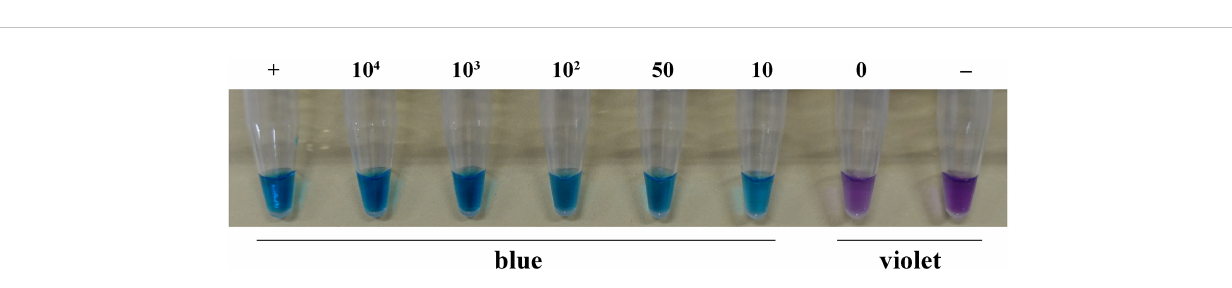
FIGURE 5 LAMP assay detection of H. annosum in basidiospore suspensions containing different numbers of basidiospores. “ + ” : positive control; “ - ” : negative control.